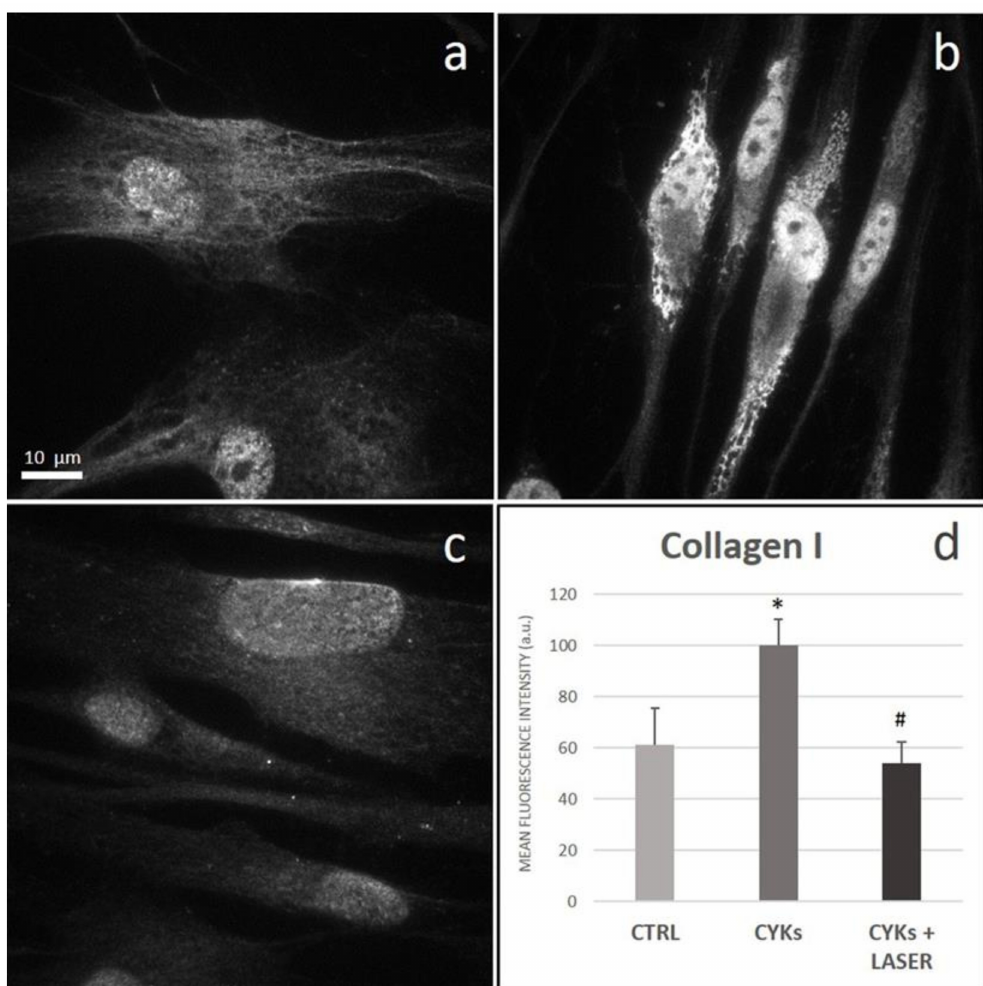
Figure 8. Effect of laser treatment on Collagen I expression and distribution. Microscopy analysis of Collagen I expression evaluated by immunofluorescence (magnification 100 × ) on NHDF in basal conditions (CTRL; panel ( a )), stimulated with IL-1 β and TNF- α for 48 h (CYKs; panel ( b )), stimulated with IL-1 β and TNF- α for 48 h and then exposed to laser treatments (3 treatments, repeated once a day, for 3 consecutive days) (CYKs + Laser; panel ( c )). Bar = 10 µ m. The histogram reports the mean pixel intensity, acquired by ImageJ software after appropriate thresholding and subsequent image masking (panel ( d )). * p < 0.05 CYKs group vs. CTRL group; # p < 0.05 CYKs + Laser group vs. CYKs group ( n =